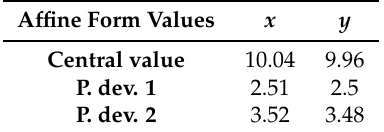
Table 1. Simple numerical example of Extended Affine